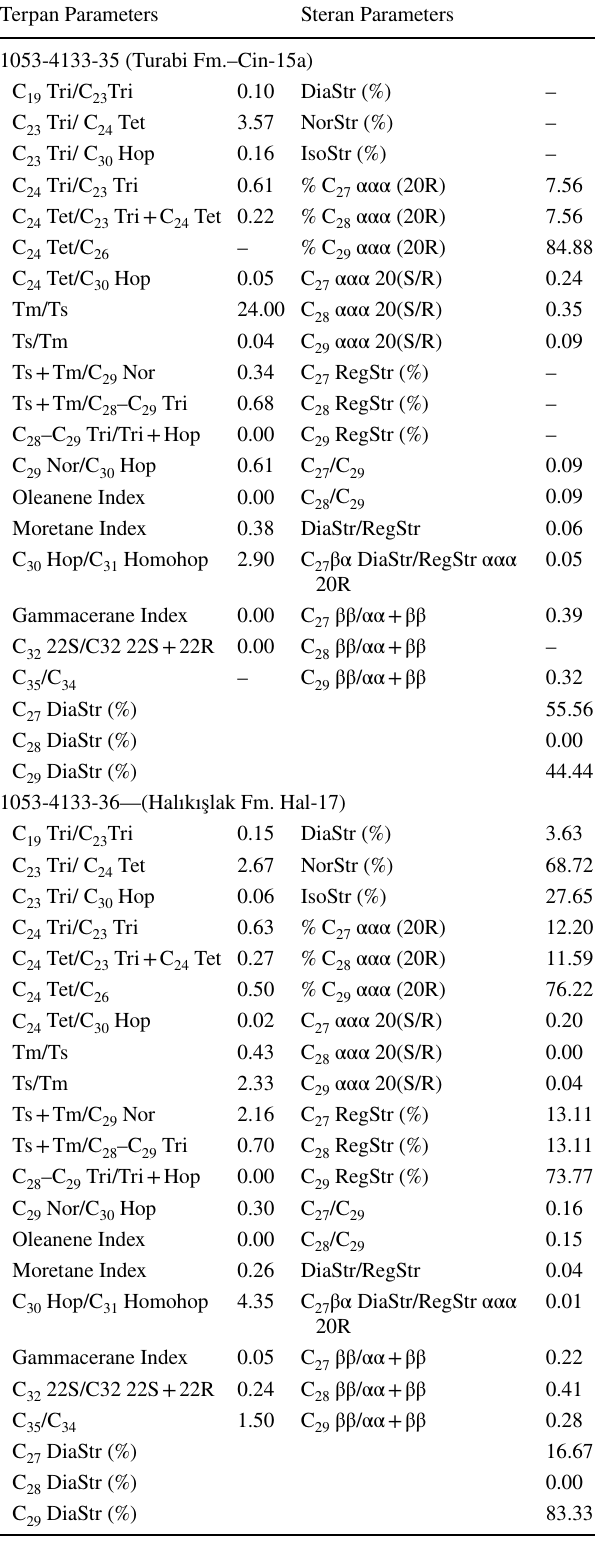
Table 4 GC-MS results of Halıkışlak and Turabi formations samples Terpan Parameters Steran